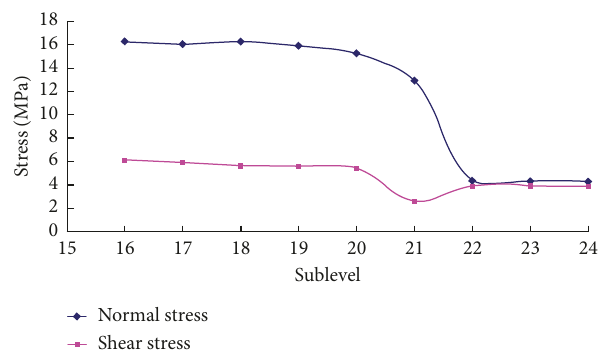
Figure 16: Relationship of stress state of fault FC2 with mining